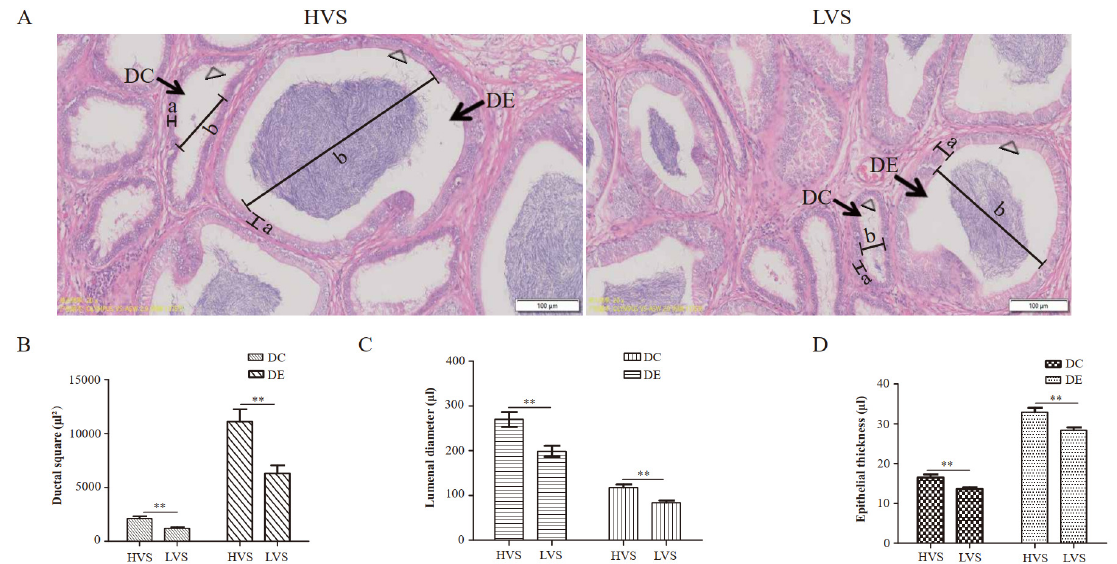
Figure 1. Histological differences of epididymis between HVS and LVS groups: ( A ) morphological differences of epididymis in drakes with different semen volume (1000×); ( B ) differences in ductal square of DC and DE between HVS and LVS groups; ( C ) differences in lumenal diameter of DC and DE between HVS and LVS groups; ( D ) differences in epithelial thickness of DC and DE between HVS and LVS groups. “DC” means ductuli conjugentes; “DE” means dutus epididymidis; “a” means the epithelial thickness; “b” means the lumenal diameter; “ Δ ” means microvilli; “HVS” means high ‐ volume semen; “LVS” means low ‐ volume semen; “**” means p < 0.01.